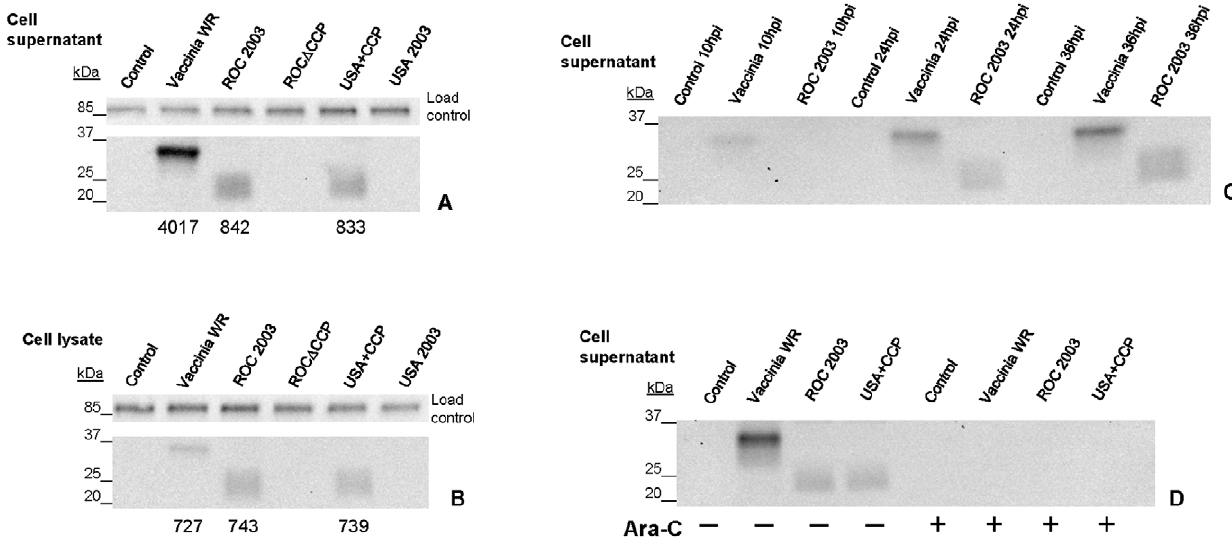
Figure 2. Invitro expression of CCP. BSC-40 cells were infected with the parental monkeypox virus (ROC 2003 or USA 2003), the recombinant monkeypox virus (ROC D CCP or USA + CCP), or vaccinia WR. At 24 hpi, supernatants (A) and cell lysates (B) were harvested and probed with polyclonal a -VCP antibody. Complement control protein homologues in monkeypox virus ( , 24 kDa) and vaccinia WR ( , 35 kDa) were detected. Human transferrin (85 kDa) was used as the load control for each well. Numerical values below each lane in blots A and B represent the intensity value of the band using the Image Lab 3.0 band density tool. Each lane was loaded with (3 m g/ml) concentrated supernatant or cell lysate. BSC-40 cells were infected with either the ROC 2003 strain of monkeypox virus or vaccinia WR and supernatant was harvested and replaced with fresh media at the indicated times (C). The harvested supernatants were analyzed using a polyclonal a -VCP antibody. VCP expression was first detected in cell supernatants at 10 hpi and monkeypox CCP expression at 24 hpi. BSC-40 cells were infected with the parental monkeypox virus (ROC 2003 or USA 2003), the recombinant monkeypox virus (ROC D CCP or USA + CCP), or vaccinia WR in the presence ( + ) or absence ( 2 ) of Ara-C. At 24 hpi, supernatants (D) were harvested and probed with polyclonal a -VCP antibody. Expression of CCP in the presence/absence of Ara-C in the West African recombinant monkeypox strain was similar to the Congo Basin strain.